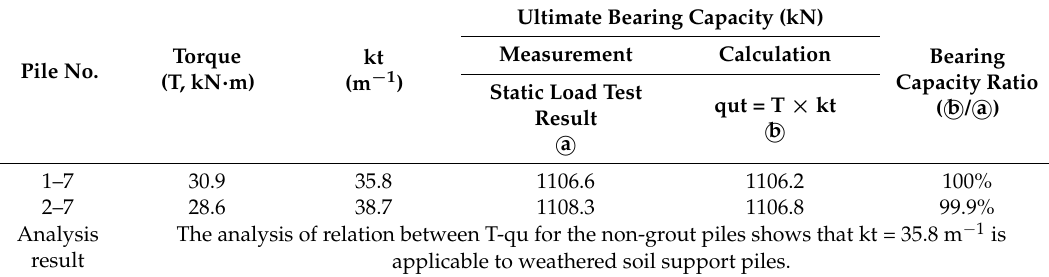
Table 12. T-qu analysis result for non-grout piles.